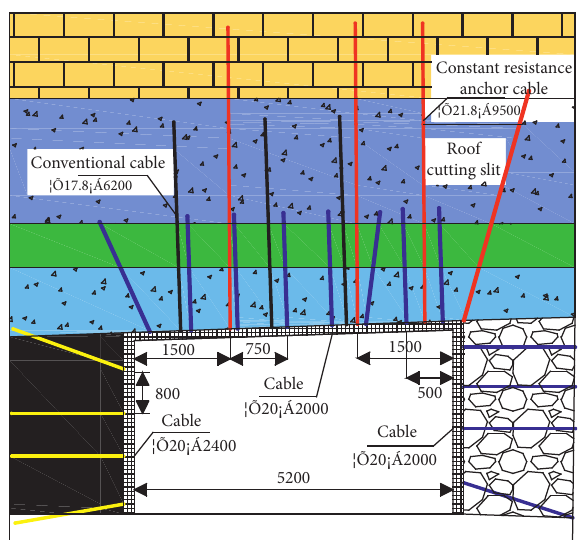
Figure 9: Support mode of II 632 haulage